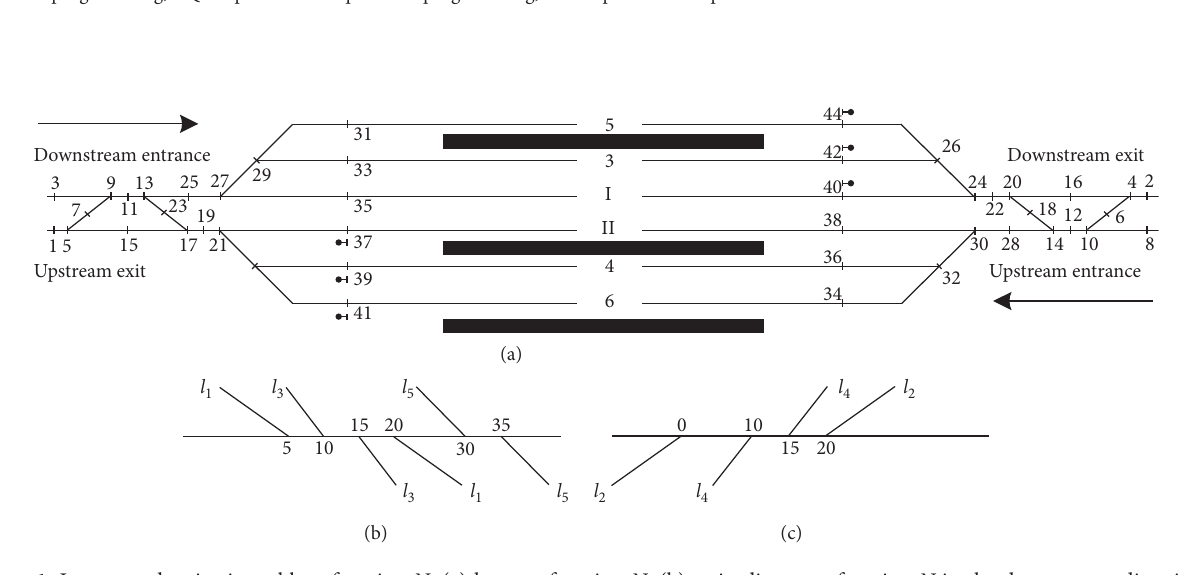
Figure 1: Layout and train timetables of station N : (a) layout of station N ; (b) train diagram of station N in the downstream direction; (c) train diagram of station N in the upstream direction.